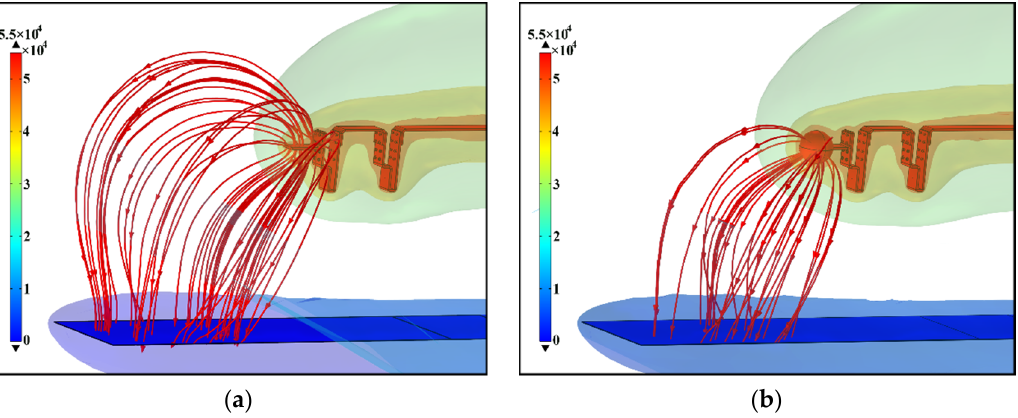
Figure 10. Effect of metal sphere on electric field streamlines at the far end of the series connected submodules: ( a ) initial condition; ( b ) after adding metal sphere.